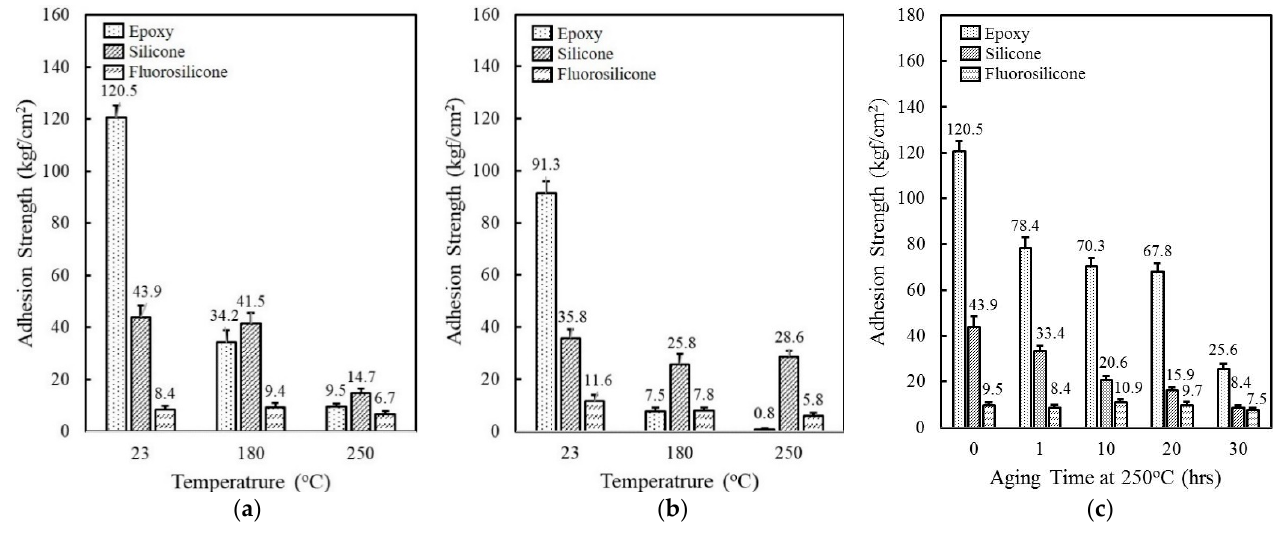
Figure 1. Comparison of adhesion strength of epoxy, silicone, and fluorosilicone resins: ( a ) Adhesion strength measured at 23 °C, 180 °C, 250 °C; ( b ) Adhesion strength measured at 23 °C, 180 °C, 250 °C after aging at 85 °C/85% RH for 168 h; ( c ) Adhesion strength as a function of aging time at 250 °C. Table 3. The swelling ratio of epoxy, silicone, and fluorosilicone resins in various